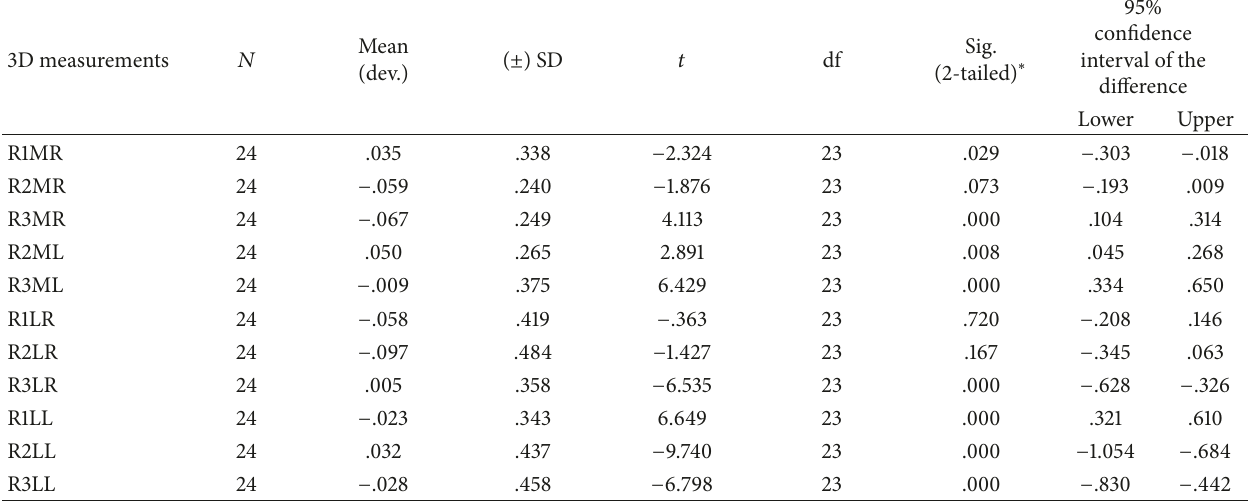
Table 2: One-sample t -test results from the deviation magnitude comparison of identical twins and same individual values.